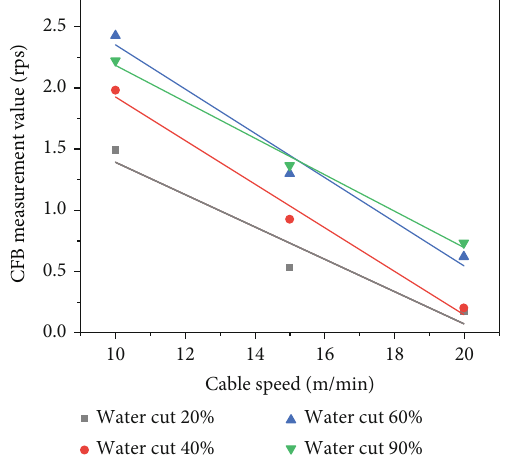
Figure 13: Relational graph of the measured value of 85 ° inclination of 100m 3 /d CFB and cable speed.